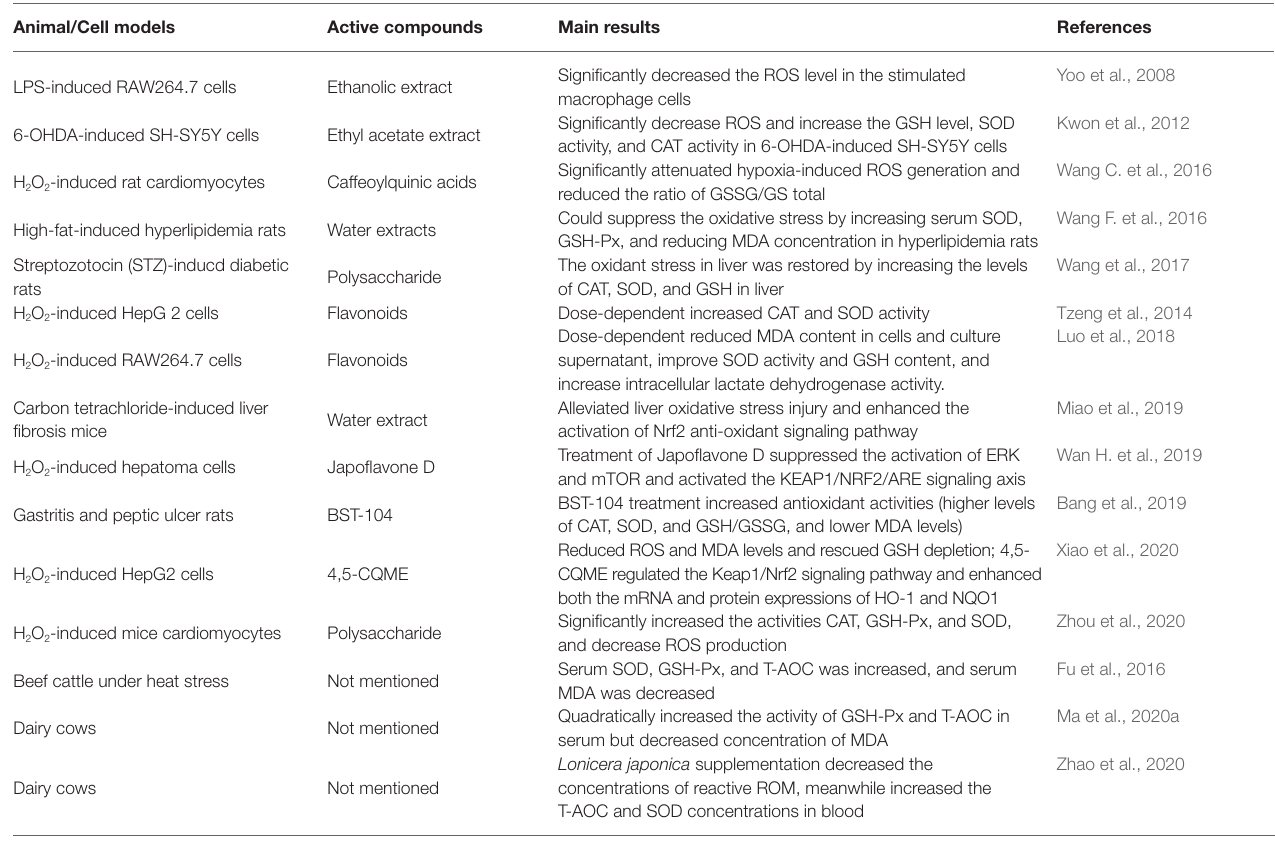
TABLE 1 | Antioxidant activity of Lonicera japonica in vitro and in vivo